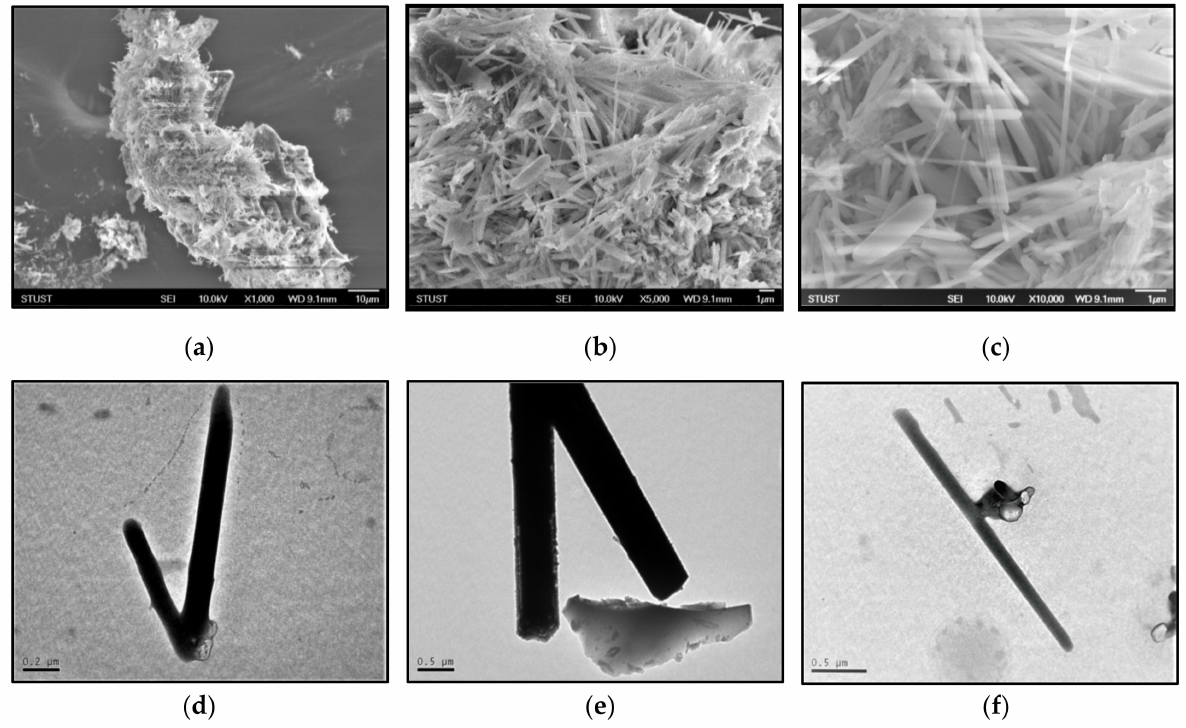
Figure 6. ( a – c ) SEM images and ( d – f ) TEM images of carbon